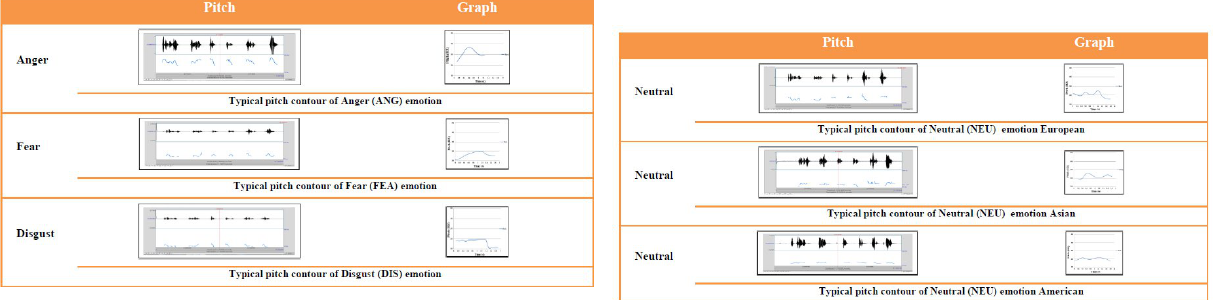
Fig. 9. European pitch contours for Anger, Fear and Disgust.